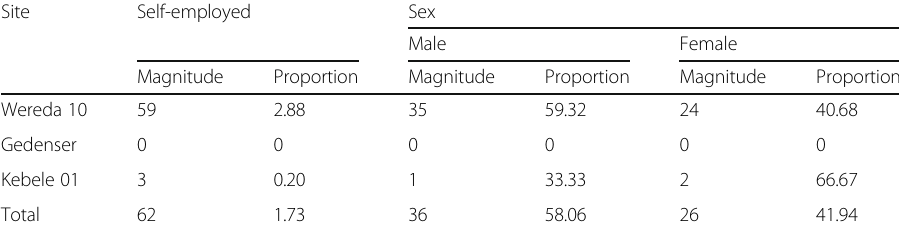
Table 7 Youth self-employment status and sex in overall project sites Site Self-employed Sex